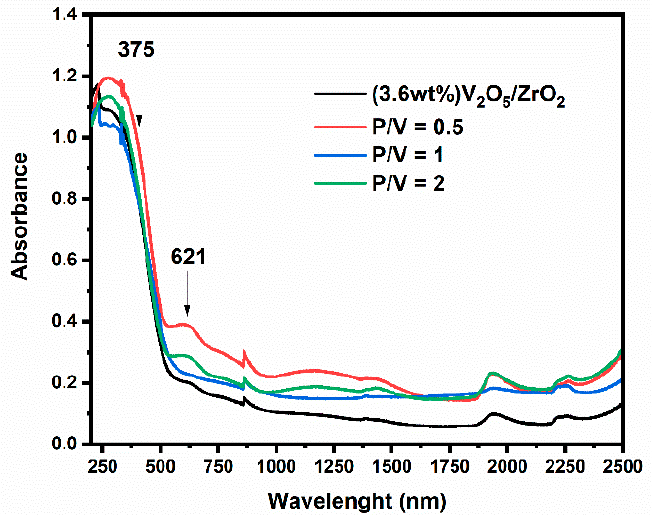
Figure 5. UV-Vis-NIR Spectra of 3.6 wt%V 2 O 5 /ZrO 2 modified by phosphate depending on